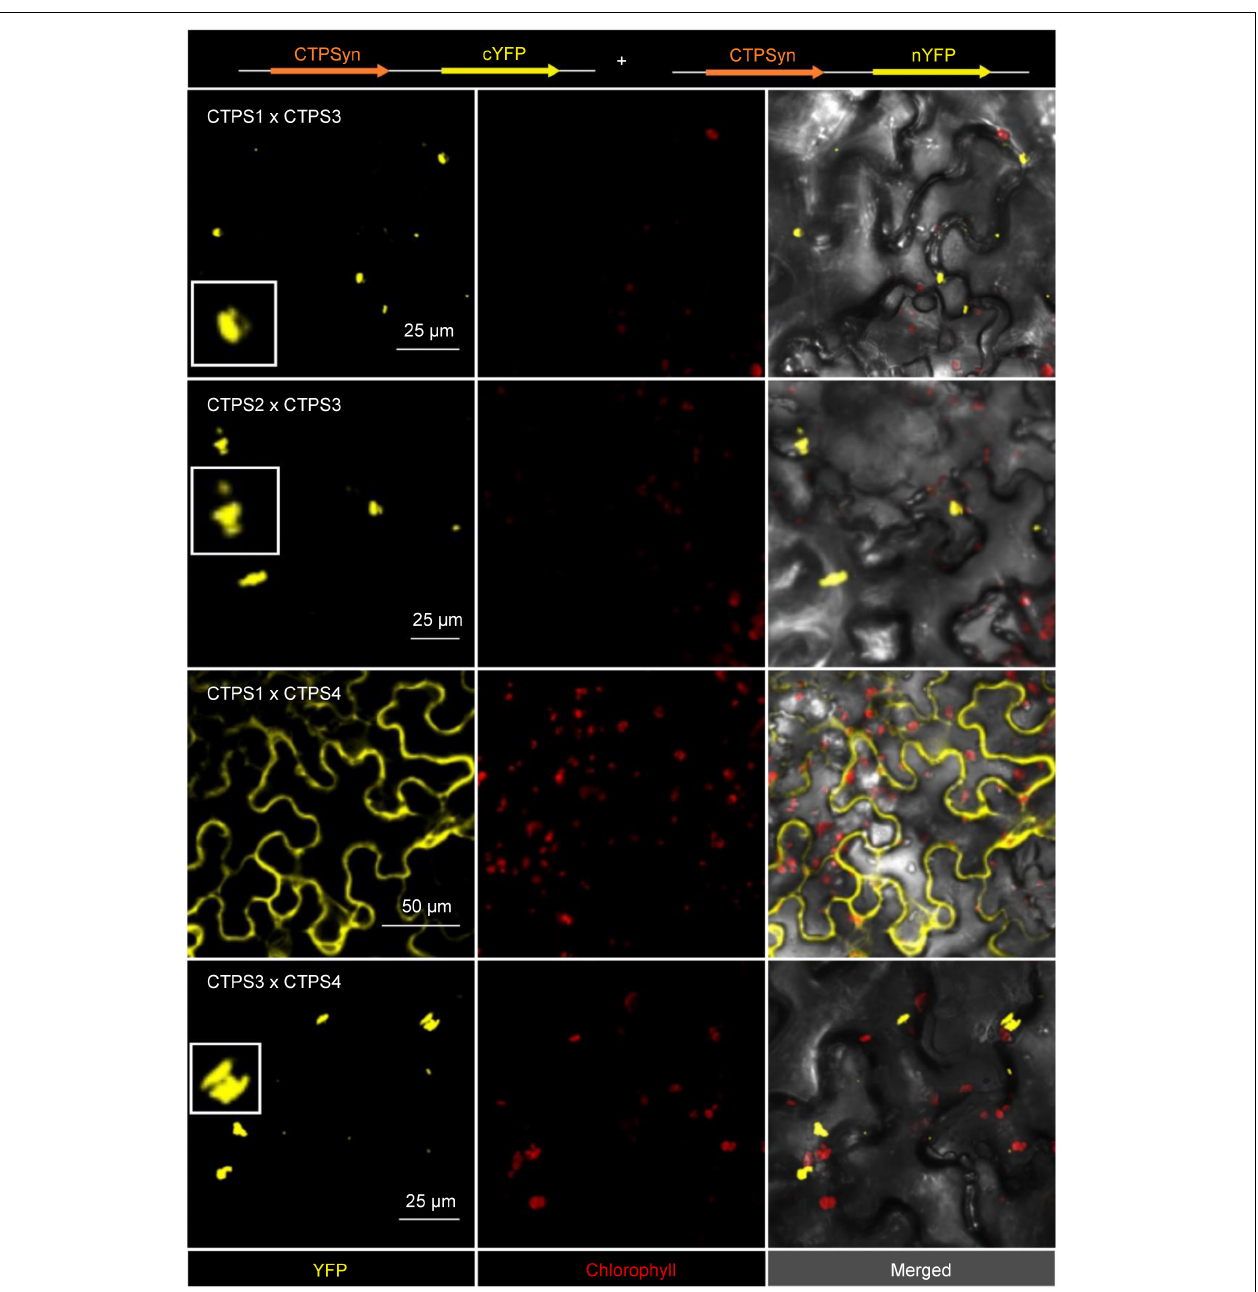
FIGURE 6 | Bimolecular fluorescence complementation (BiFC) assay to determine interactions of the CTPS 1-4. Shown are the interaction of combinations of each two different isoforms after transient expression in Nicotiana benthamiana leaves. Zoom in on selected filaments are shown in white boxes. CTPS was fused C- or N-terminally in the vector pUB with either a C- or N-terminal YFP fragment. Confocal laser scanning was applied for imaging. CTPS, cytidine triphosphate synthase; YFP, yellow fluorescent